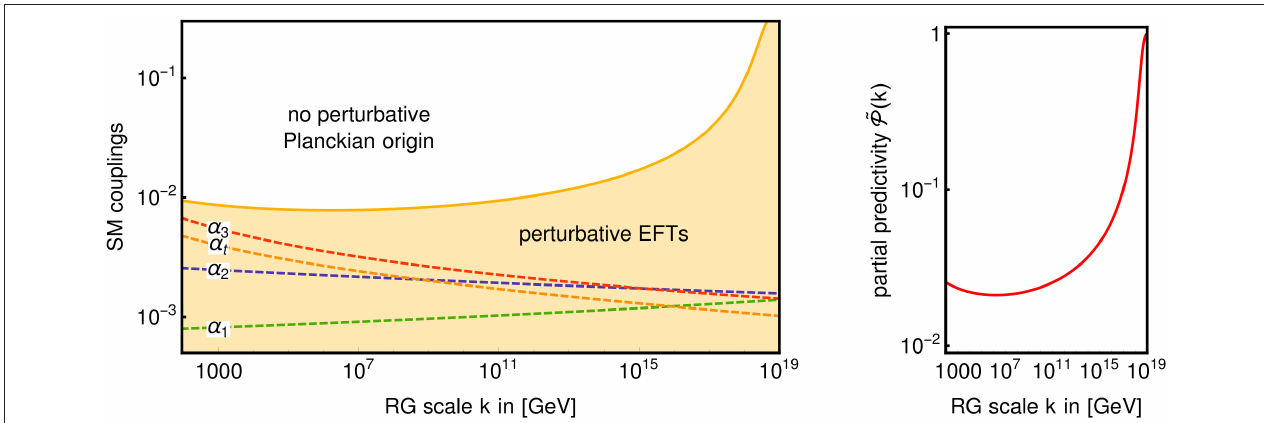
FIGURE 3 | (Left) RG flow of the SM gauge-Yukawa theory. The shaded region indicates values for α t which can originate from a perturbative EFT at the cutoff scale 3 Planck . The focusing of this region toward the lower scales exemplifies the partial predictive power of the SM as an EFT. The dashed trajectories indicate the RG flow of α 3 , α 2 , α 1 , and α t , matching observed values at the electroweak scale. (Right) Evolution of the partial predictivity measure with the RG